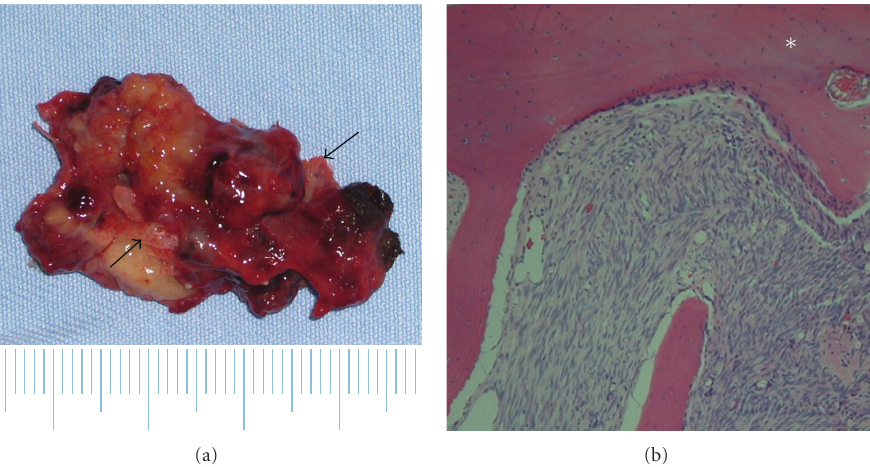
Figure 3: Macroscopic (a) and microscopic (x100 magnification) (b) features of the excised tumor. The spindle cells are arranged in a patternless fashion, and new bone formation consisting of randomly organized trabeculae lined by osteoblasts was observed in the tumor. black arrows and ∗ asterisk: bone tissue.